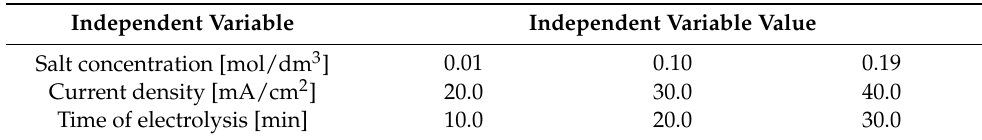
Table 1. Values of chosen independent variables for Box–Behnken